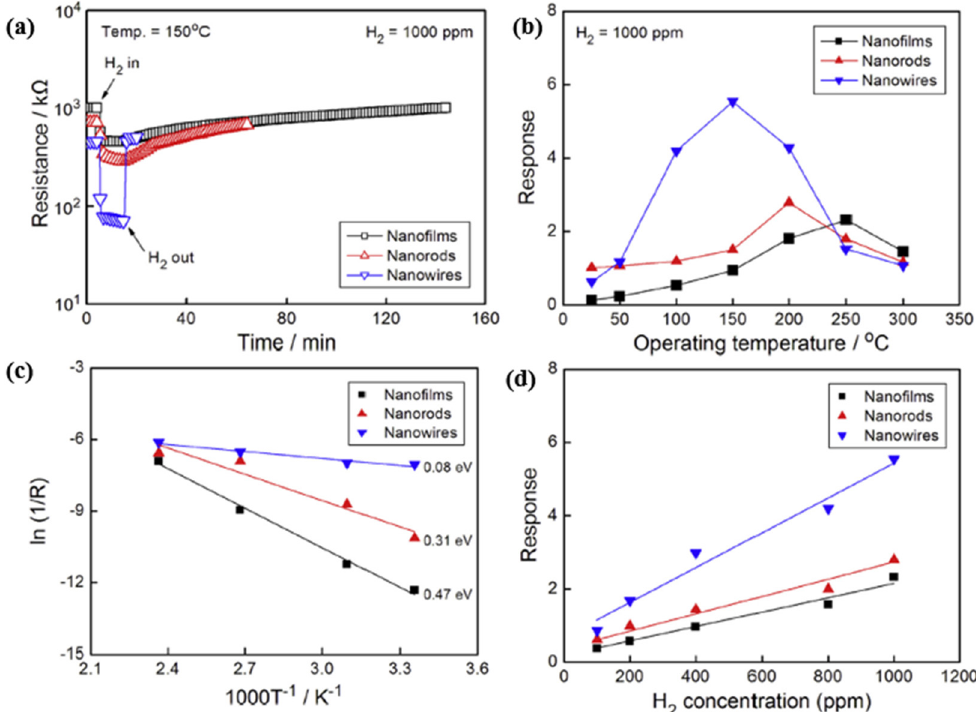
Figure 22. ( a ) Changes in the resistance of gas sensors based on SnO 2 nanomaterials upon exposure to 1000 ppm H 2 at an operating temperature of 150 °C. ( b ) Responses of SnO 2 nanomaterials upon exposure to 1000 ppm H 2 as a function of the operating temperature. ( c ) Arrhenius plots representing the electrical conductivities of SnO 2 nanomaterials before H 2 in- troduction versus the reciprocal of the operating temperature (1/T). ( d ) Relationships between the response and H2 concentration for SnO 2 nanofilms at 250 °C, SnO 2 nanorods at 200 °C, and SnO 2 nanowires at 150 °C [105]. Copyright (2015), with permission from Elsevier.